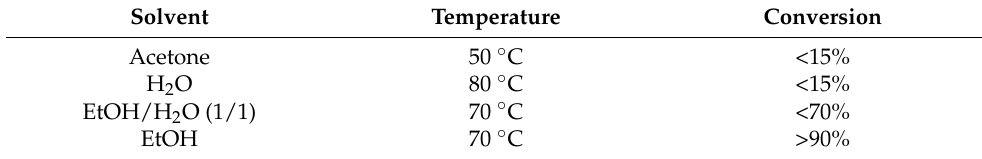
Table 5. Nature of solvent and temperature for oxyacetic acid of anacardic acid ( 5 ) synthesis. Solvent Temperature Conversion Acetone